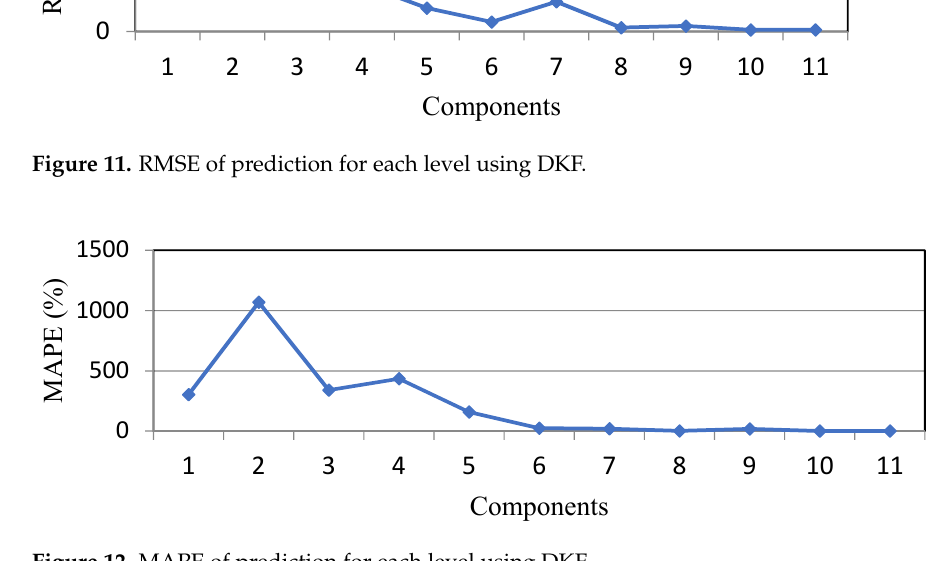
Figure 12. MAPE of prediction for each level using DKF.